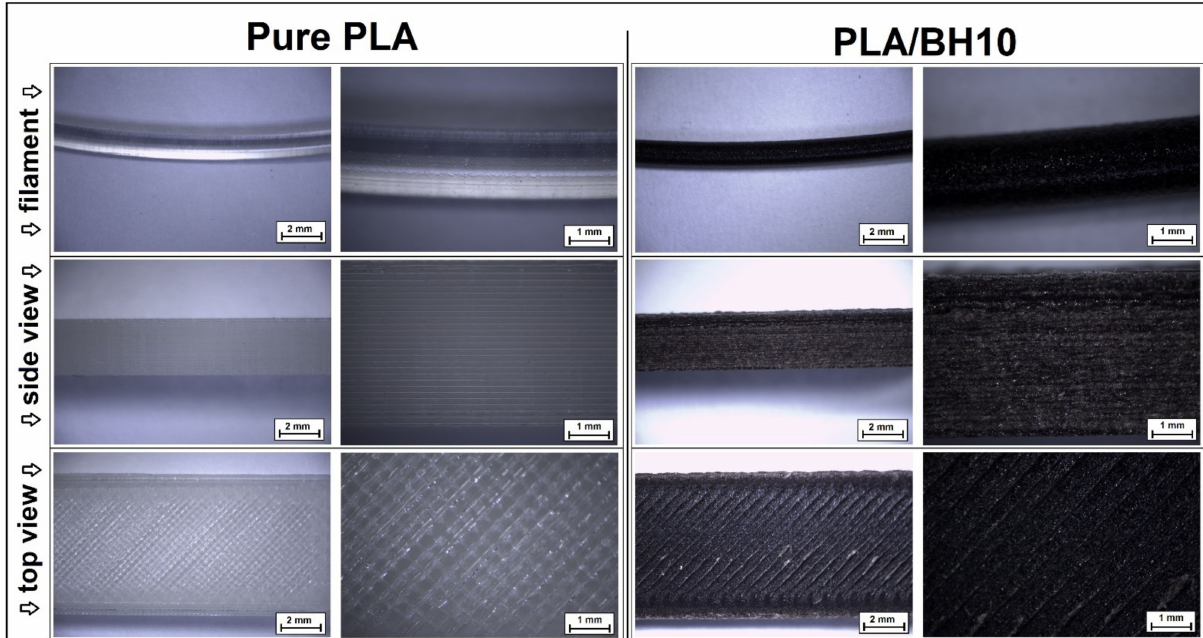
Figure 3. The appearance of the prepared pure PLA and PLA/BH10 samples. Pictures present the filament material, and side and top view of the printed sample.